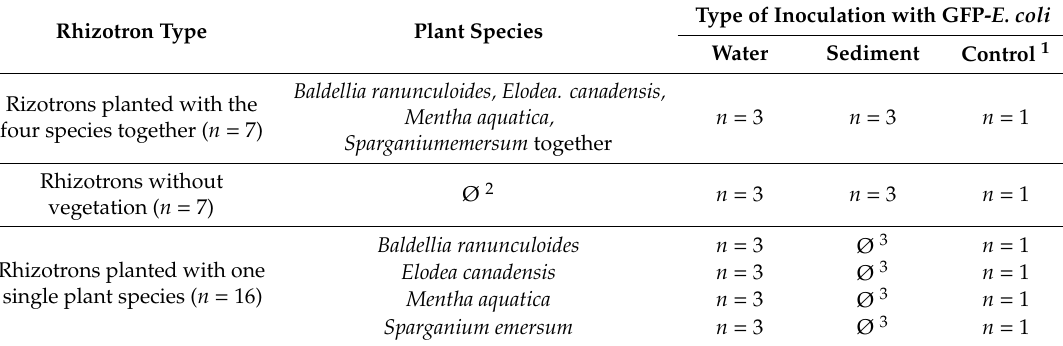
Table 1. Experimental design. Planted and unplanted rhizotrons inoculated with GFP- Escherichia coli in water or sediment.